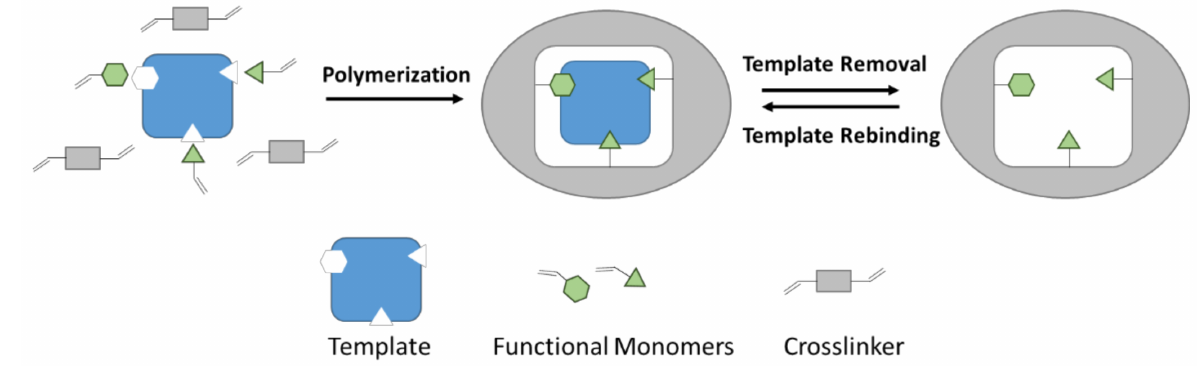
Figure 1. Schematic illustration of imprinting and